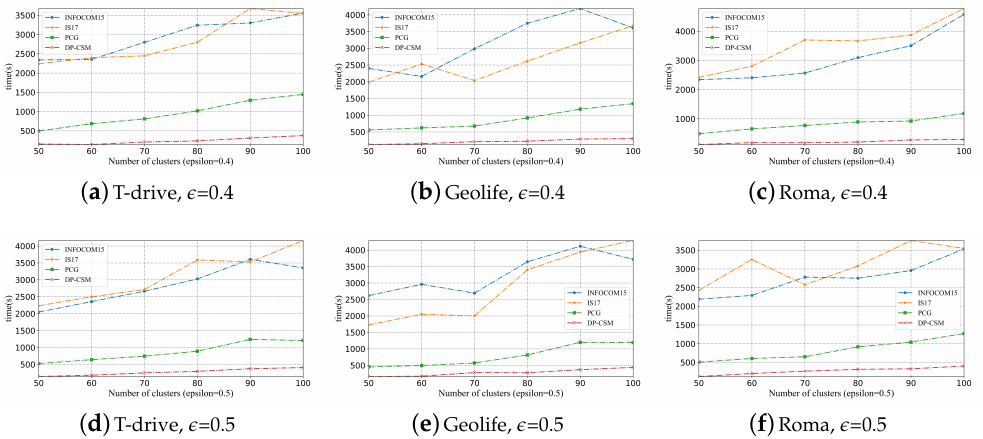
Figure 12. Impact of k on the efficiency of the four methods. k is a parameter of the k -means algorithm, representing the number of clusters. In these experiments, we fix the size as |D| = 2000 for each datasets, and choose two kinds of privacy budget, i.e., (cid:101) = 0.4, and (cid:101) = 0.5. For each epsilon and dataset, we vary k from 50 to 100, and compare the running times of the four